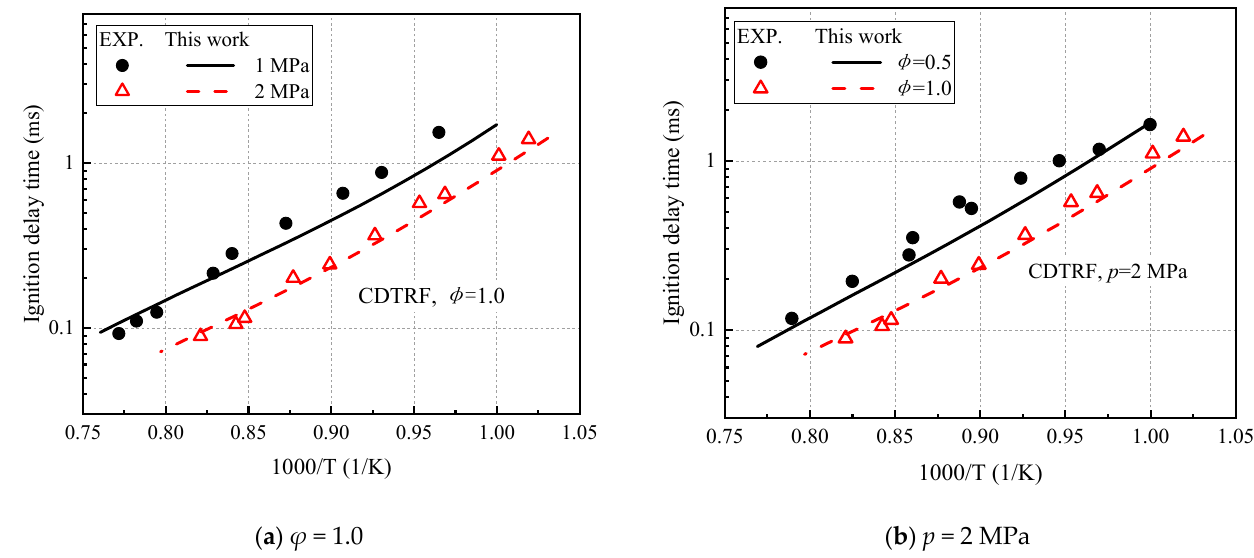
Figure 10. Verification of the ignition delay time of CDTRF. ( a ) φ = 1.0; ( b ) p = 2 MPa.